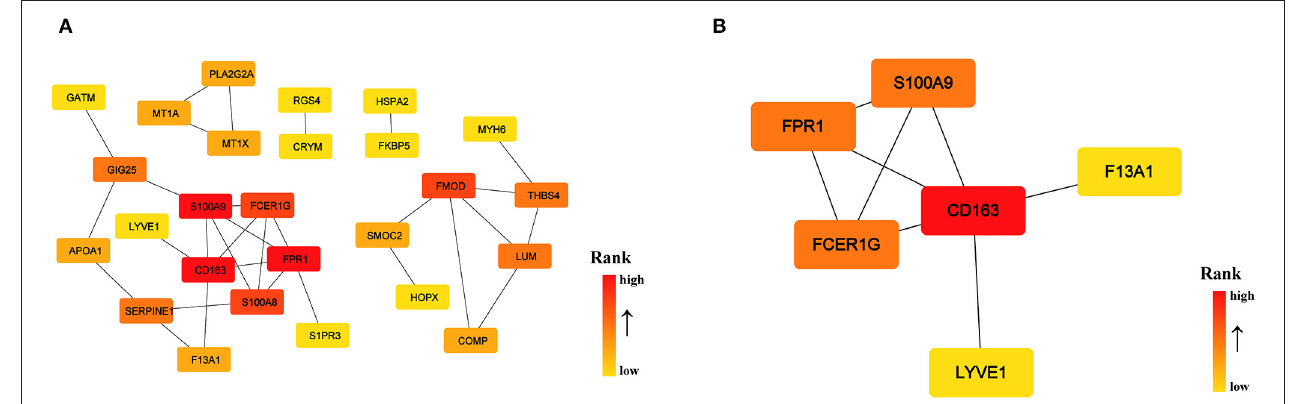
FIGURE 7 | PPI network of significant DEGs (|log2FC| > 1.0) in the GSE36961 and GSE141910 dataset. (A) PPI network of significant DEGs. (B) Cluster recognized by MCODE in significant DEGs.